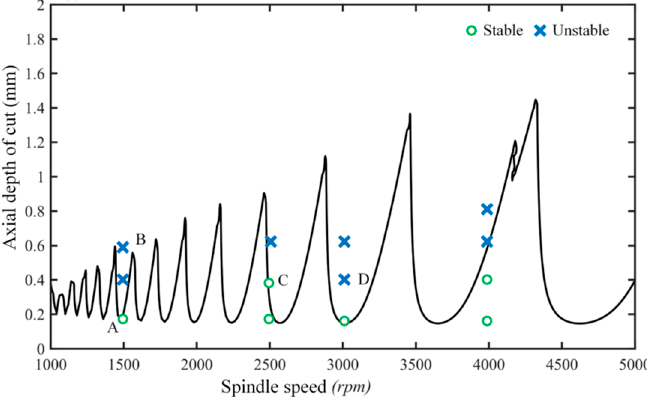
Figure 8. Stability lobe diagrams at the measured point 2.